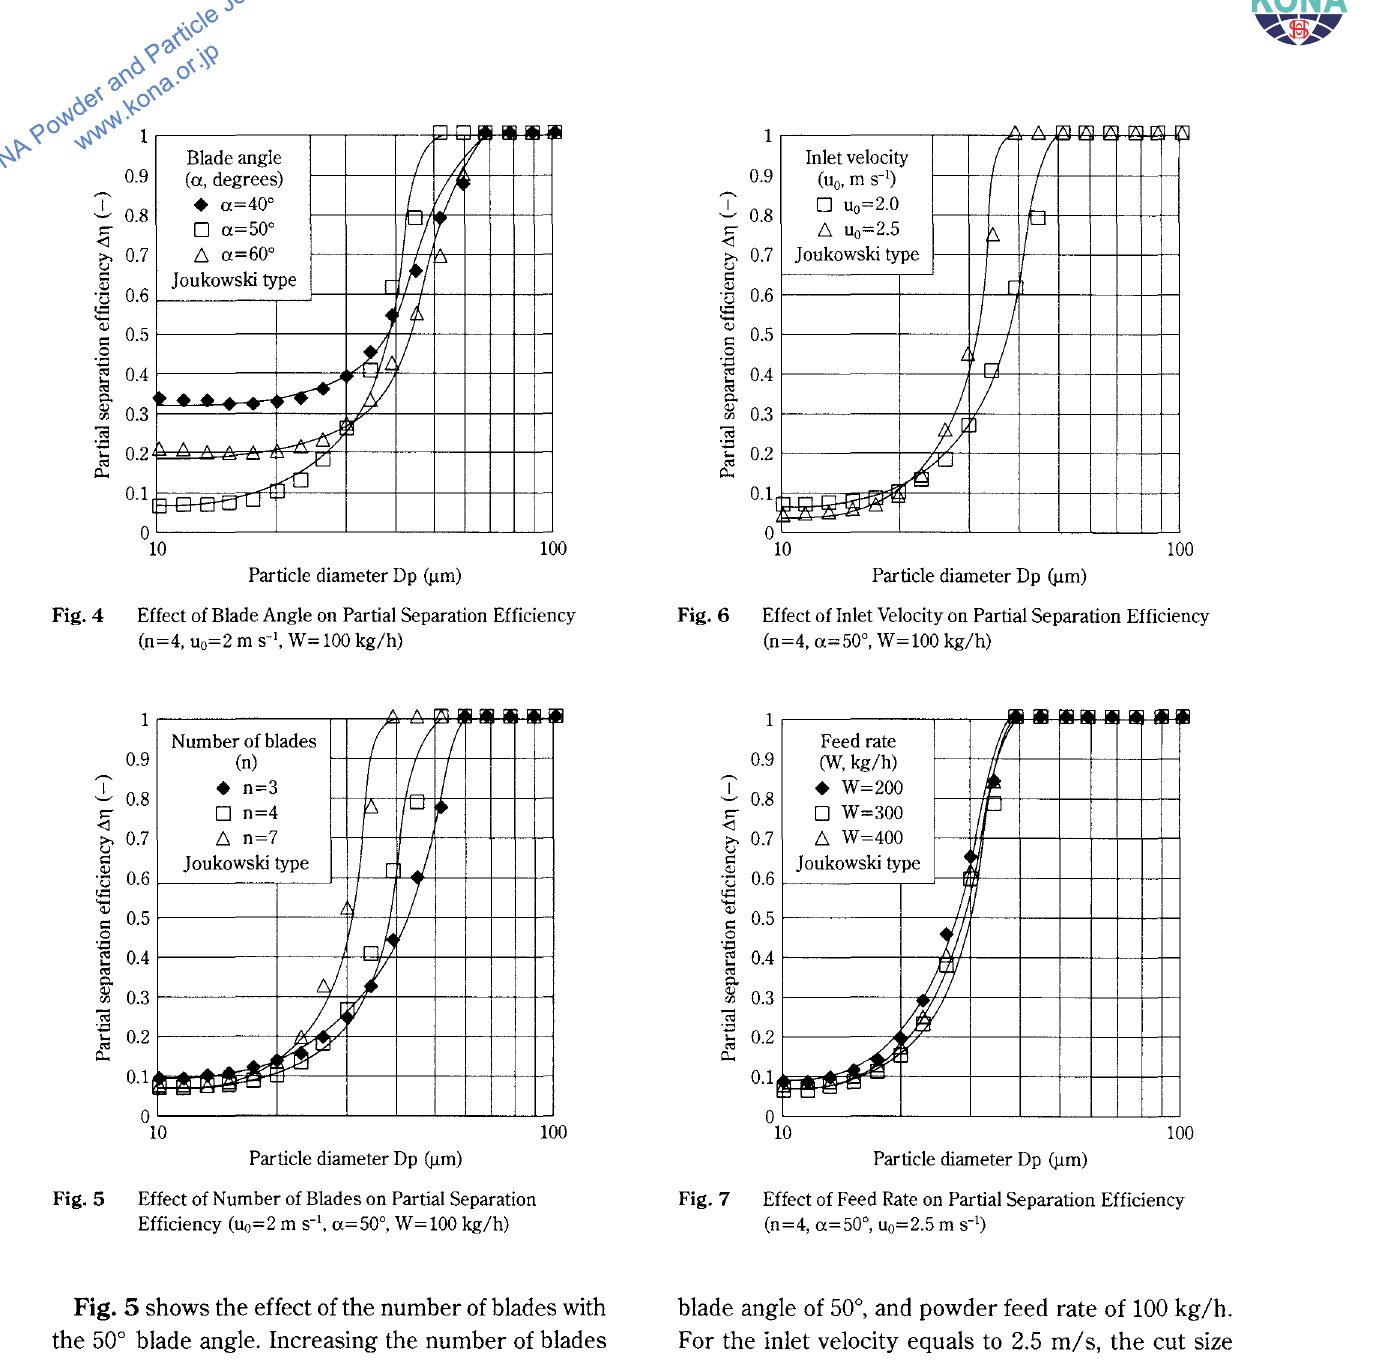
Effect of Feed Rate on Partial Separation Efficiency (n=4, a=50°, u 0 =2.5 m s- 1)